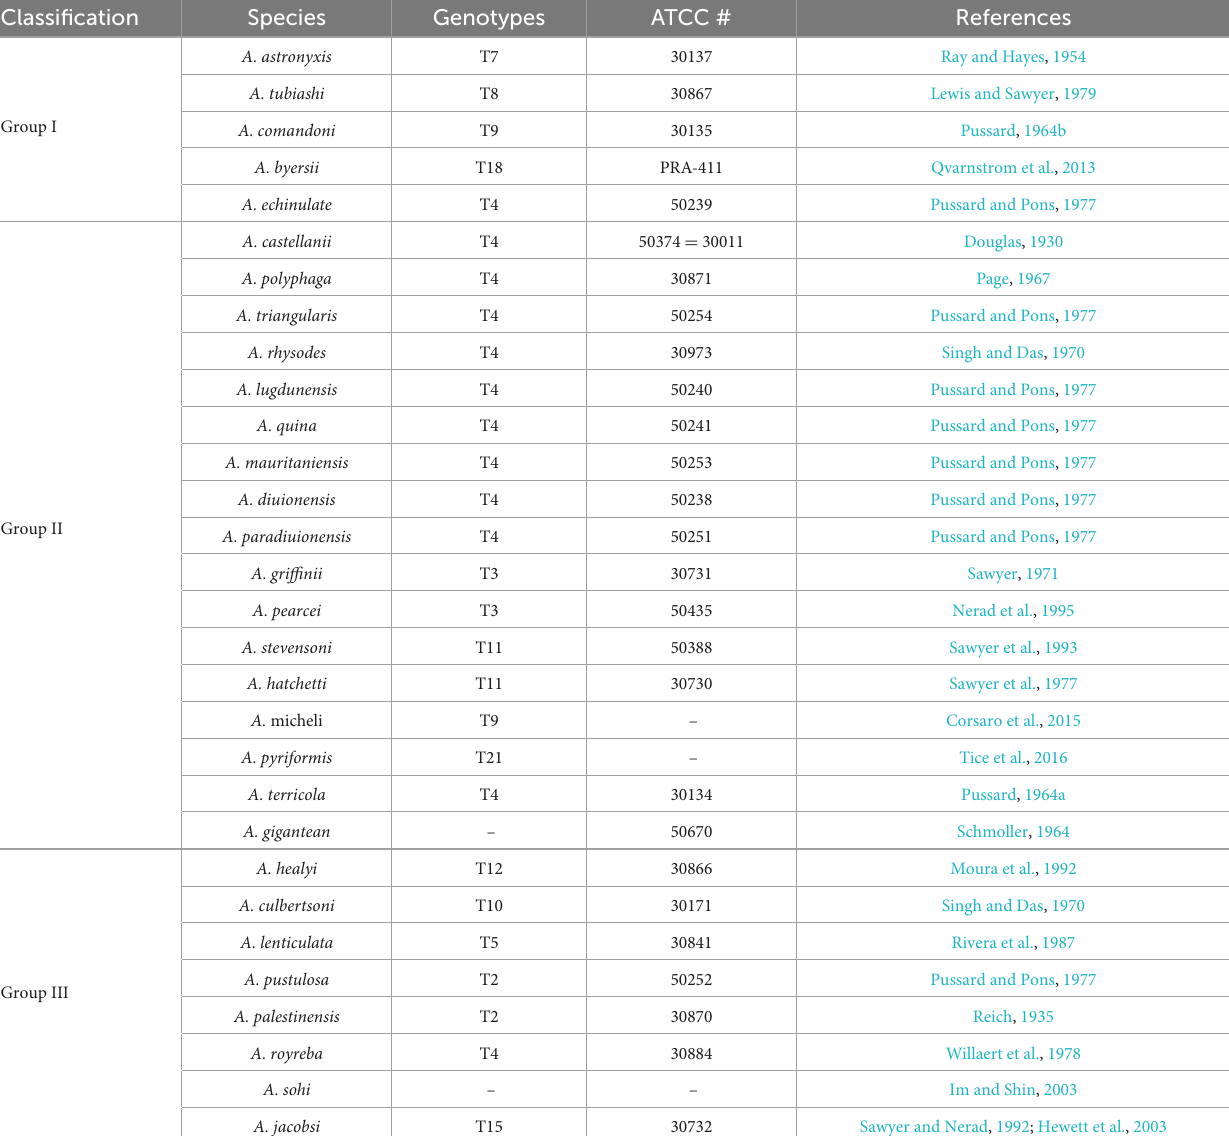
TABLE 1 The traditional classification of Acanthamoeba